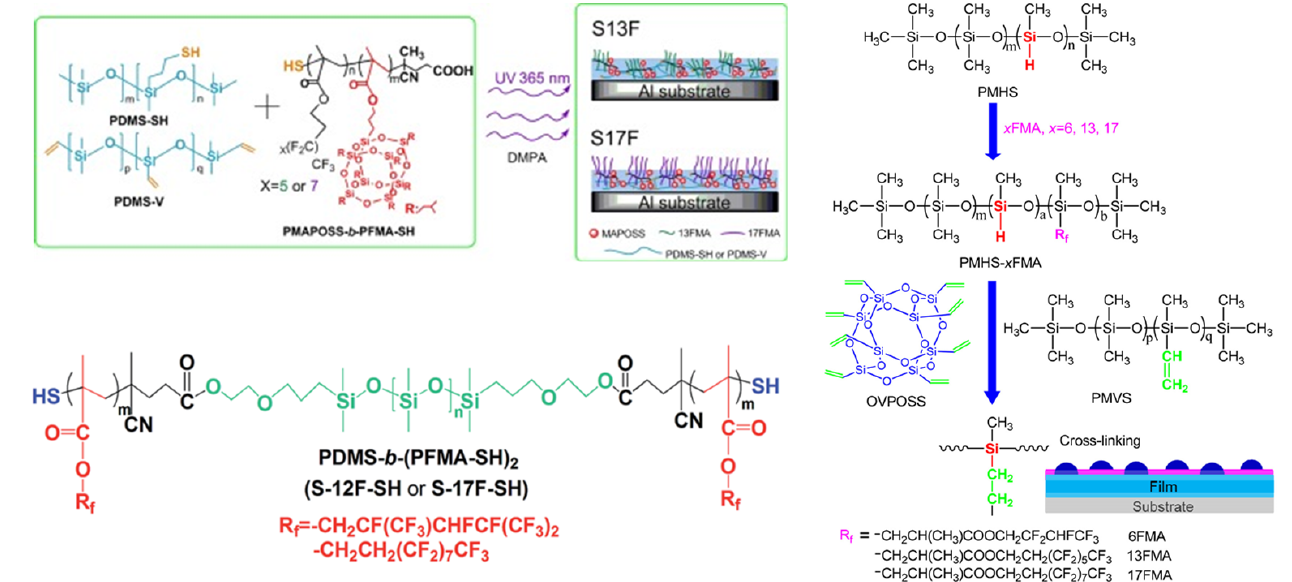
Figure 2. Polysiloxane- and fluorine-containing coatings for icephobicity [18,20,21]. Figures reproduced corresponding publishers Elsevier, RSC.